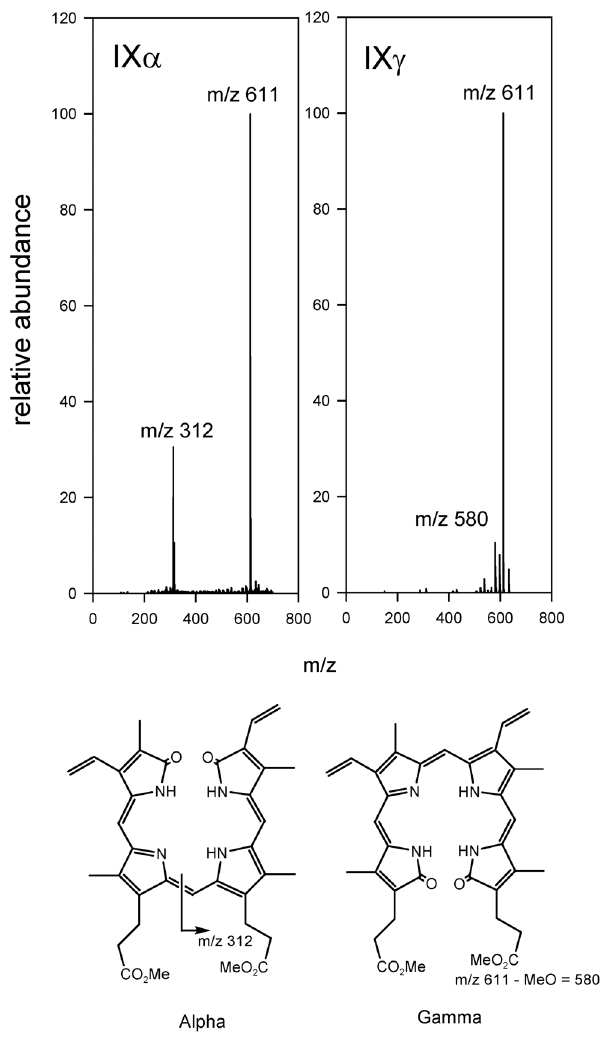
Figure 9. Mass spectra of dimethyl ester derivatives of reaction products. Spectra are from analysis of actual reaction mixtures and identified by comparison with those of the methyl ester derivatives of authentic biliverdin IX a and IX c . The lower panels are structural rationalizations of the observed cleavage patterns of biliverdin IX a and IX c methyl